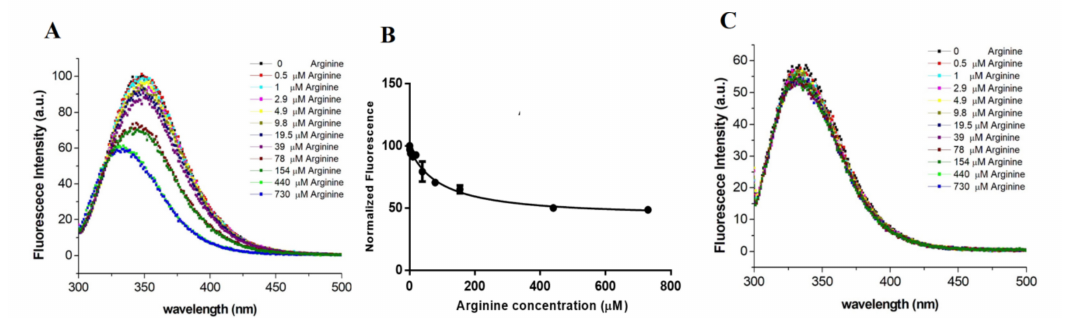
Figure 4. ( A ) E ff ect of the arginine binding on the Trp fluorescence of TmArgBP 20 − 233_F76W . The concentration of the protein was 45 µ M. ( B ) Maximum of the fluorescence intensity is reported as a function of the concentration. ( C ) Fluorescence measured on a TmArgBP 20 − 233_F76W sample that was initially saturated with arginine and then extensively